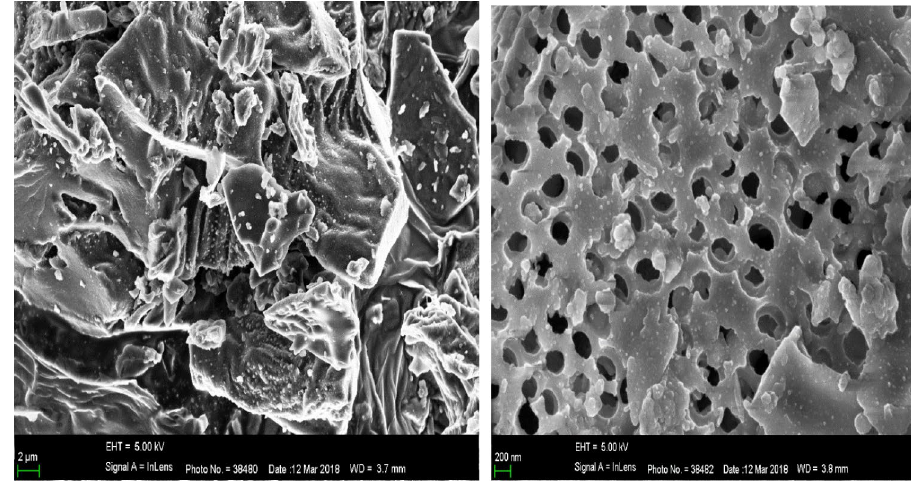
Fig. 2 a The micrograph of OPR. b The micrograph of